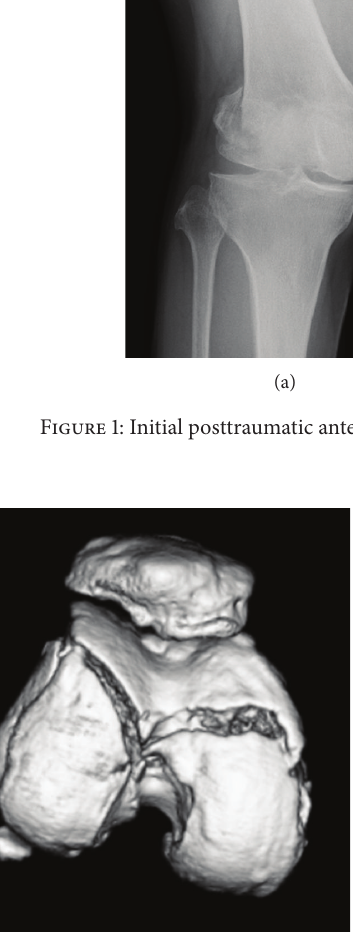
Figure 2: A three-dimensional computed tomographic image of the femoral articular cartilage of the right knee, showing the bicondylar Hoffa